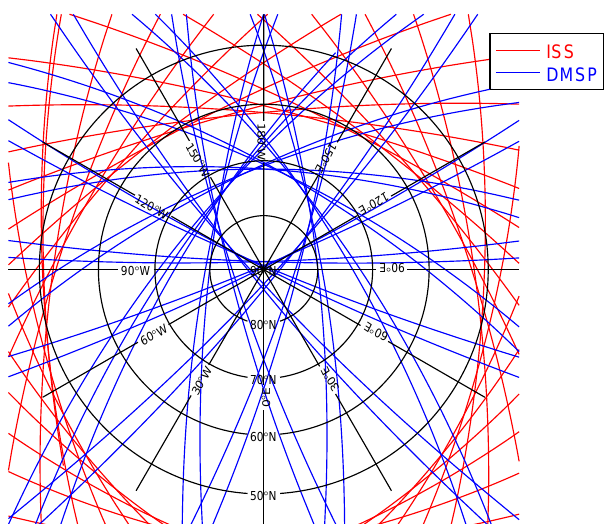
Figure 2. A comparison of the orbits of the International Space Sta- tion (red) and the DMSP F15 spacecraft (blue). The lower inclina- tion of the ISS’ orbit means it skims the auroral oval rather than cutting through